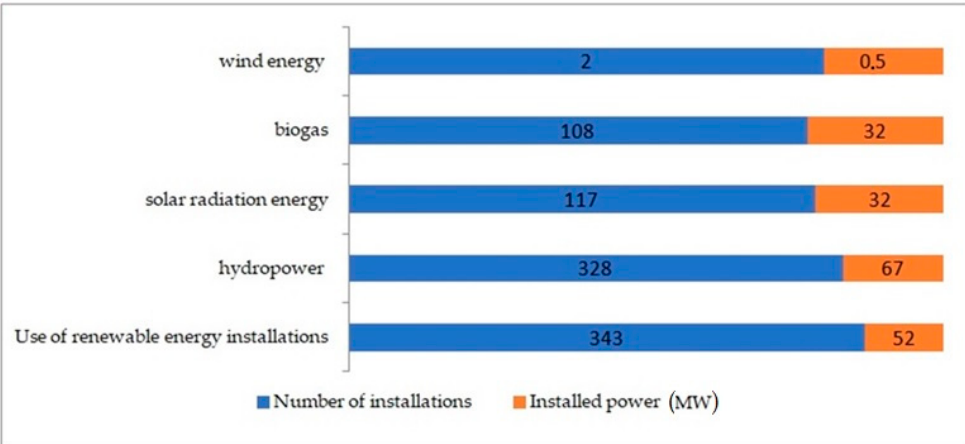
Figure 16. Energy production in small RES installations in 2016–2020 (GWh) [61].